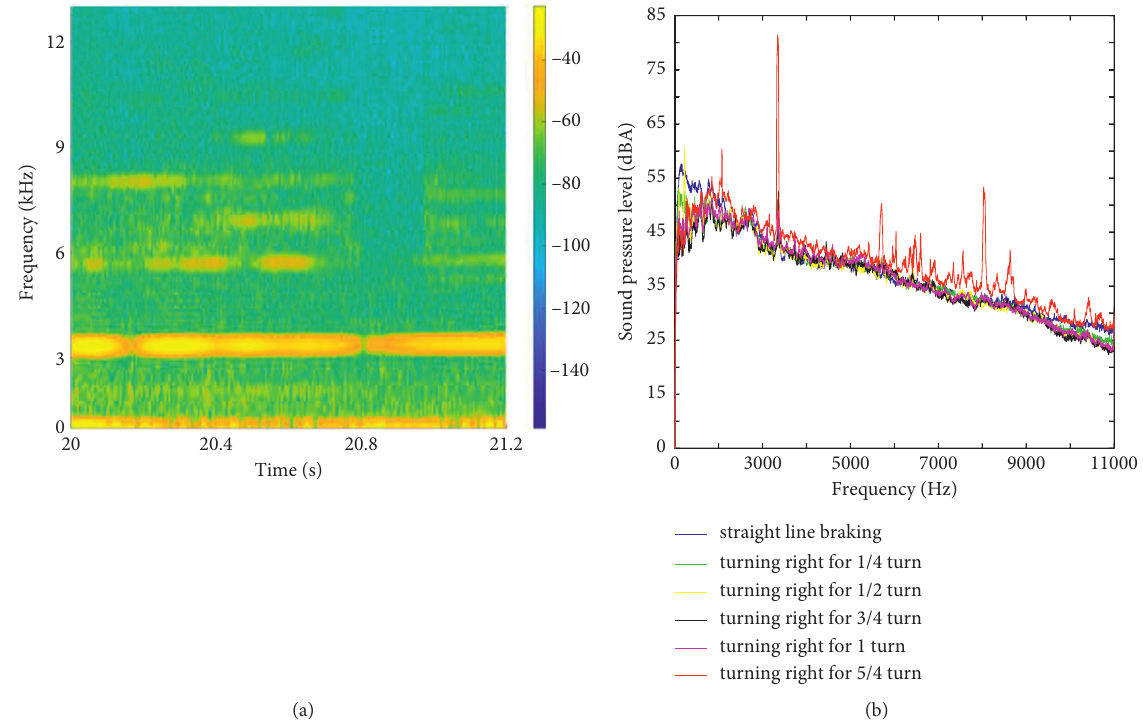
Figure 4: Characteristics of steering brake squeal. (a) Analysis of time domain. (b) Analysis of frequency domain.